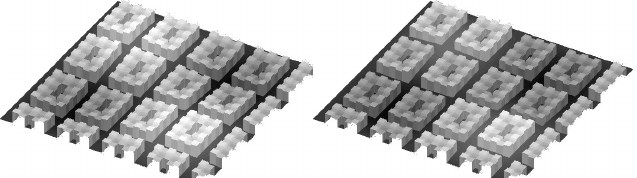
Figure 2: Synthetically generated DSM composed from urban blocks (nDEM) and a rolling ground (DTM) – left: simple DTM+nDEM, right: correctly added nDEM to min(DTM) in each building area